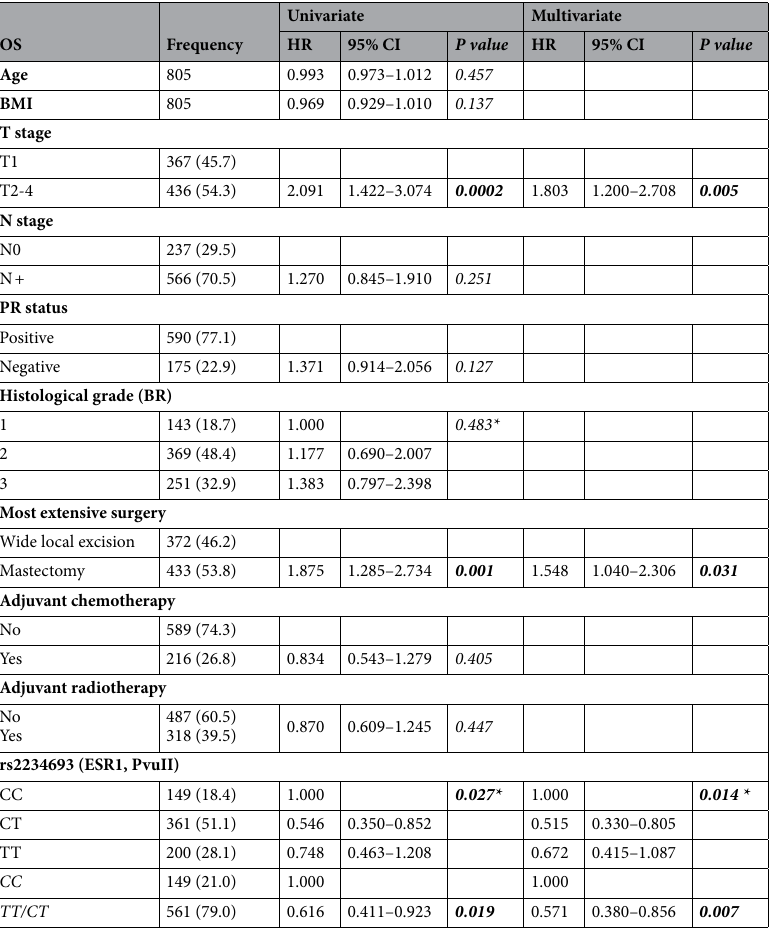
Table 3. Univariate and multivariate Cox models of OS for different variables and rs2234693. OS, overall survival; HR, hazard ratio; CI, confidence interval; BMI, body mass index; PR, progesterone receptor; BR, Bloom Richardson. The multivariate analyses are compensated for T stage and type of surgery. Bold values indicate P < 0.05. *Global